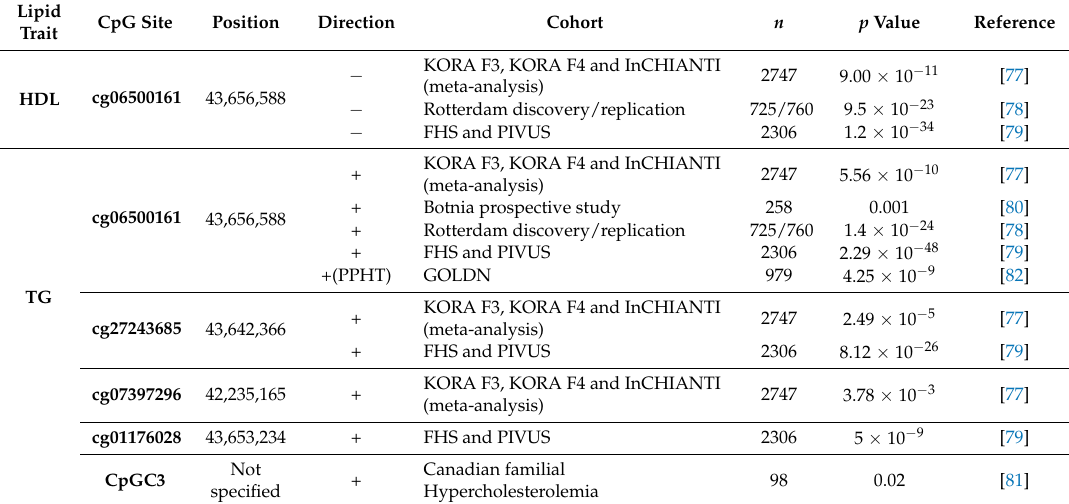
Table 1. Association between methylation at different ATP-binding cassette G1 (ABCG1) CpG loci and plasma lipid levels. HDL, high-density lipoprotein; TG, triglycerides; KORA, cooperative health research in the region of Augsburg; InCHIANTI, aging in the chianti area; FHS, Framingham heart study; PIVUS, prospective investigation of the vasculature in Uppsala seniors; PPHT; postprandial hypertriglyceridemia; GOLDN, genetics of lipid lowering drugs and diet